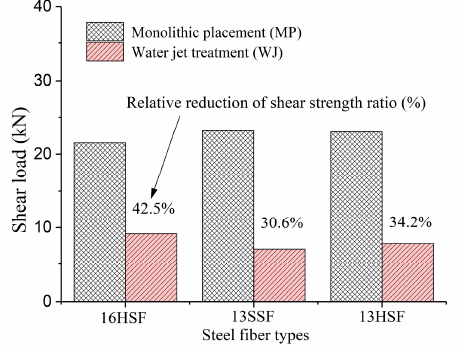
Figure 15. Relative reduction of the shear strength ratio with different fiber types.